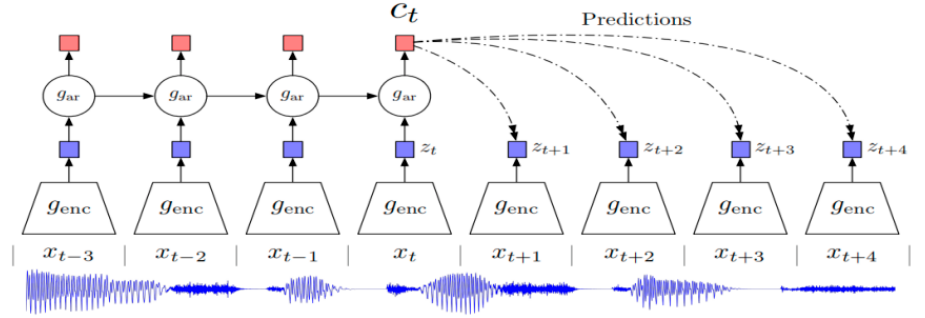
Figure 2. Overview of Contrastive Predictive Coding.